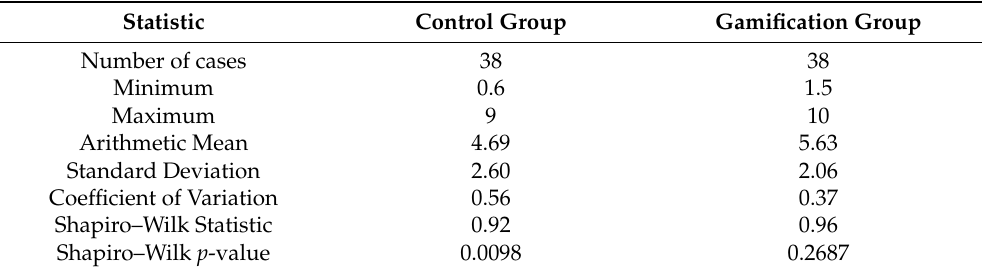
Table 1. Descriptive statistics about the mark obtained by the students using a traditional methodol- ogy (control group) and using Classcraft ® (gamification group).